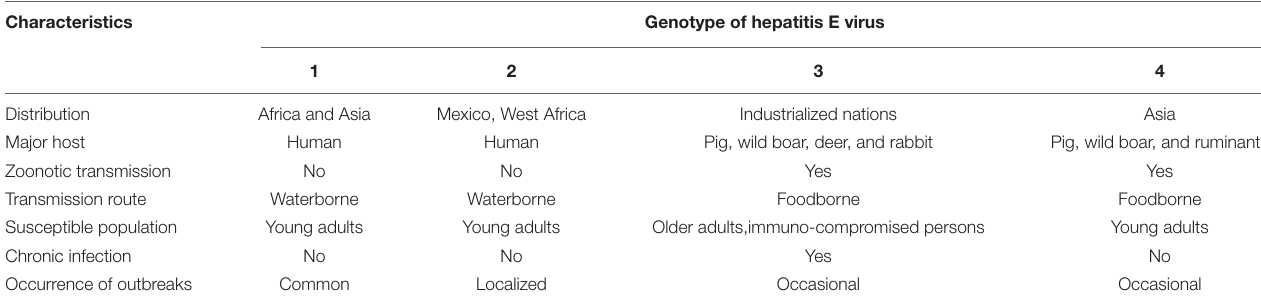
TABLE 2 | Differences in the transmission of hepatitis E virus genotypes in humans around the